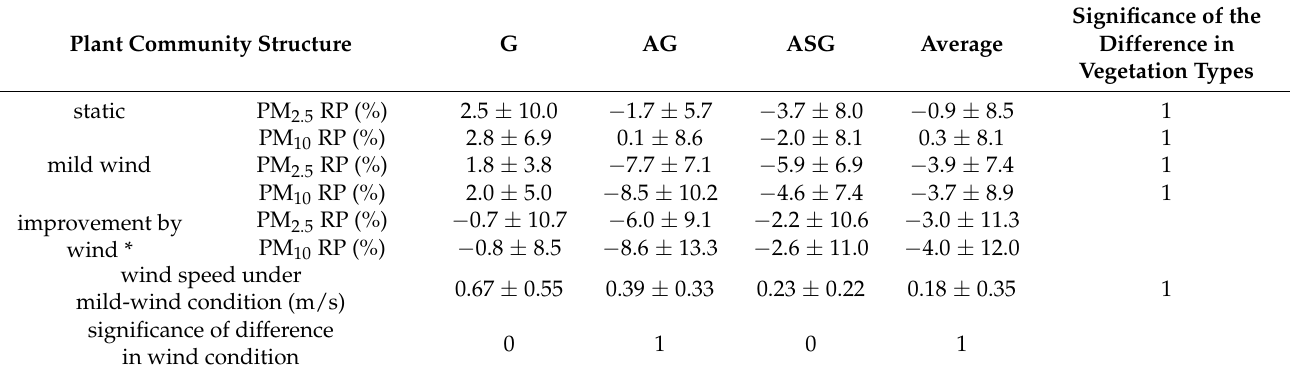
Table 3. The average PM removal percentage (RP, unit: %) and wind speed (WS, unit: m/s) statistics for the three types of vegetation. Plant Community Structure G AG ASG Average